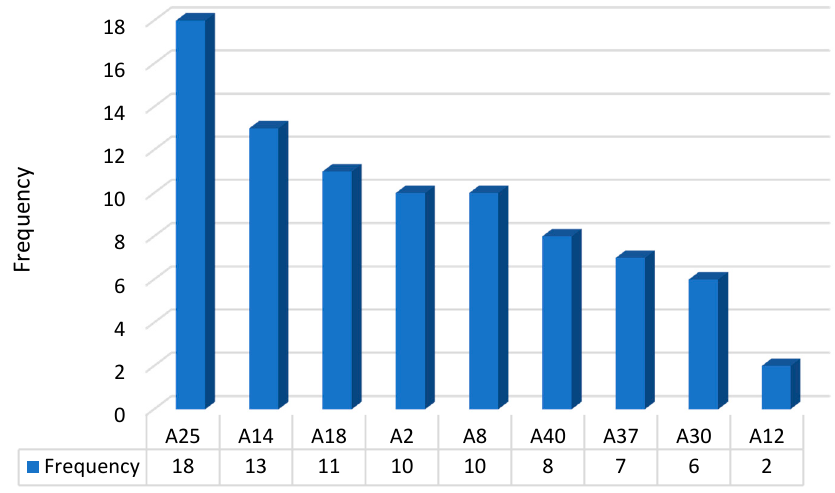
Figure 3. Item frequency in the 26 association rules for healthcare needs (A45: provide medical allowances).